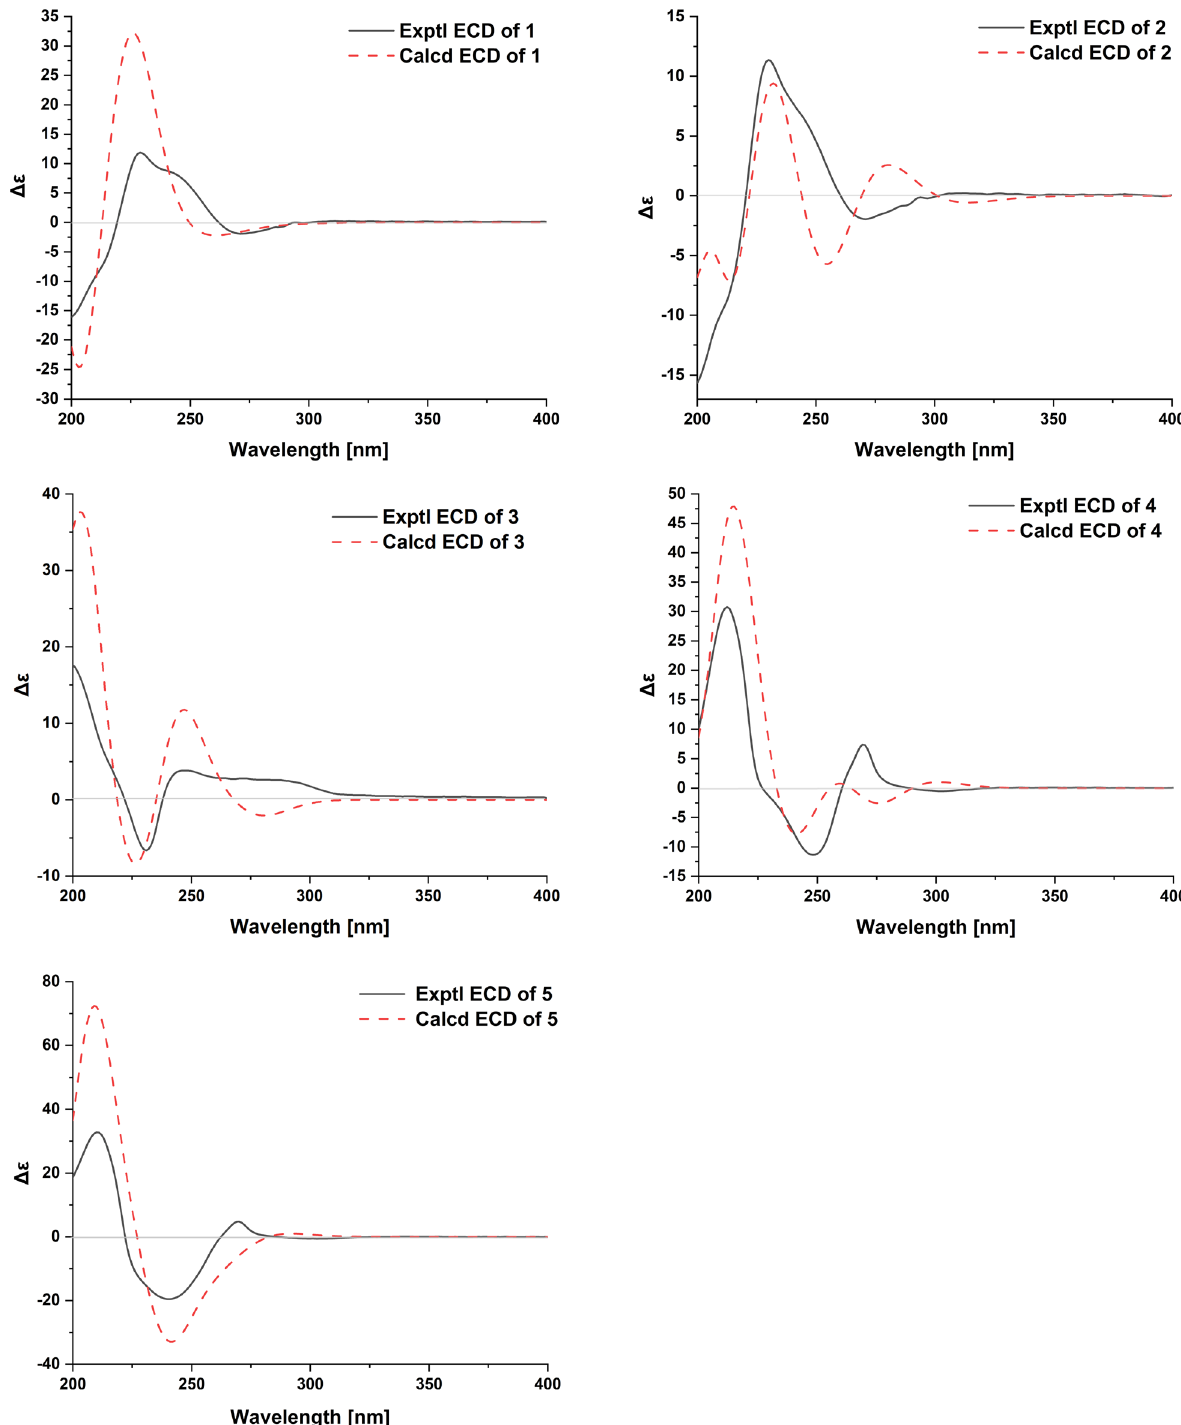
Fig. 4 Experimental and calculated ECD of uncarialines A‑E ( 1 – 5